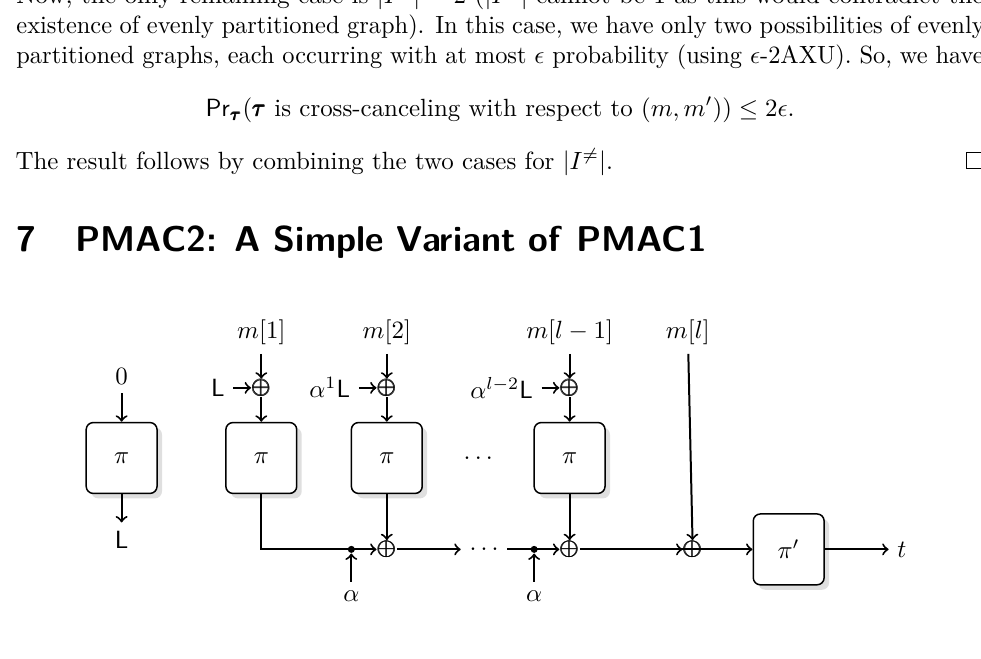
Figure 7.1: PMAC 2: A message m is padded with 10 ∗ to get m [1] || m [2] || . . . m [ l ] where each m [ i ] is an n -bit string. L is obtained as πππ (0) where πππ ← field GF (2 n